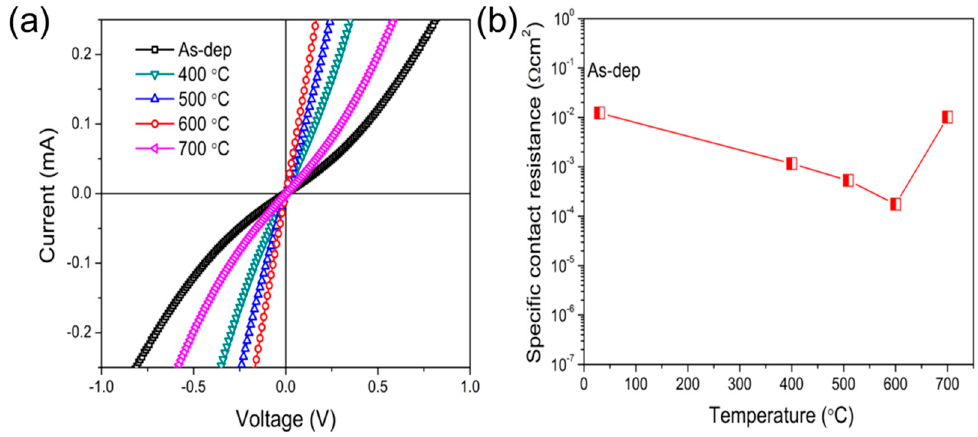
Figure 1. ( a ) Current–voltage (I–V) curves of the PdAl / Au metal stack contacts to p-AlGaN as a function of annealing temperature. ( b ) Specific contact resistance ( ρ c ) as a function of annealing temperature of PdAl / Au / p-AlGaN ohmic contacts. Table 1. Electrical characteristics of metal alloyed ohmic contact on p-AlGaN with various metallization schemes.